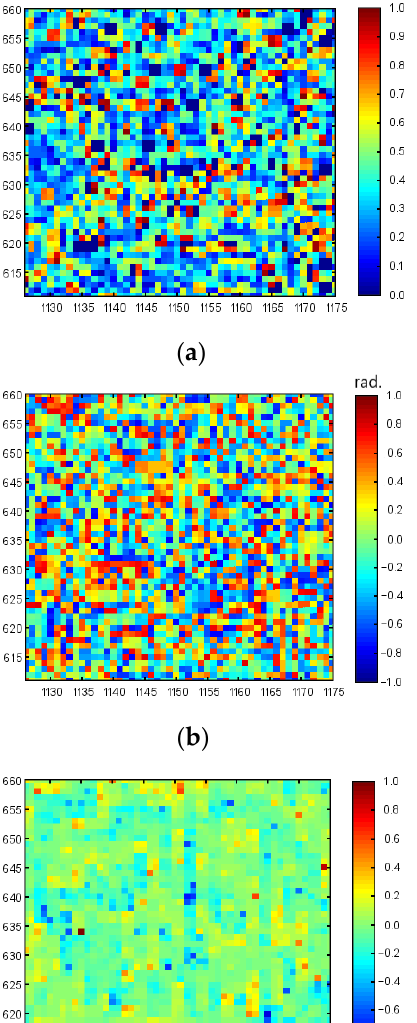
Figure 3. Coordinate distributions of the polarization degree 𝑃 ( a ), azimuth α ( b ), ellipticity β ( с ) of the radiation ellipse, and the corresponding histograms ( d – f ) of the object under research. Coordinate intensity distributions and histograms of two invariants of the diffuser surface structure matrix (𝑀 14 , 𝑀 41 ) were obtained, providing azimuthally stable infor- mation about the optically anisotropic properties of the object under investigation Figure 4.